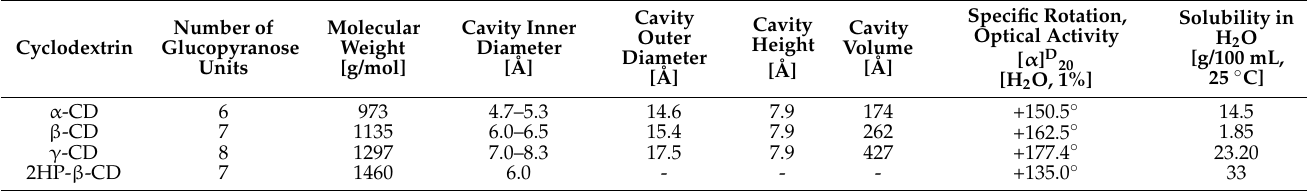
Table 1. Selected physicochemical properties of CDs